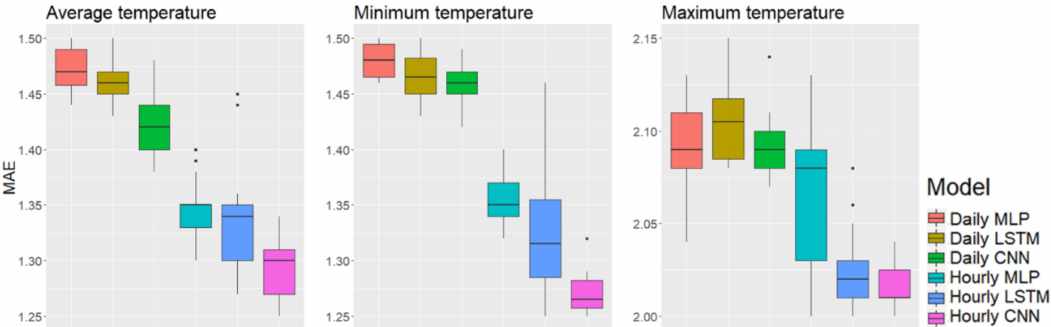
Figure 4. Box plots of the best performance among the di ff erent input lengths in the metropolitan area, Seoul.